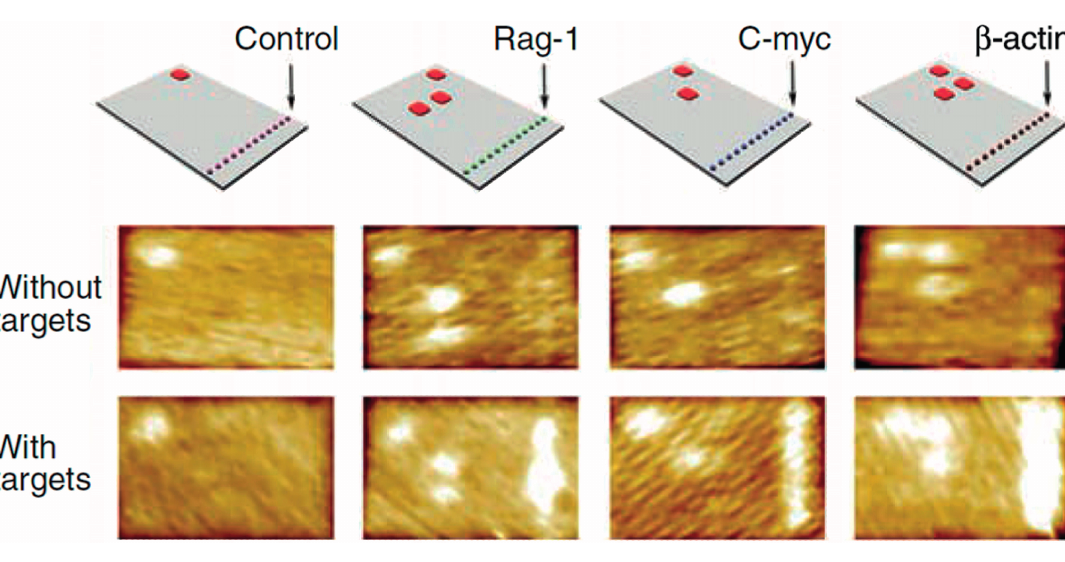
Figure 3. RNA detection using bar-coded DNA origami tiles and AFM analysis. The probe molecules are aligned in a row on the right side of the tiles, and different probes are distinguished from each other with the bar-code located on the top left corner of the tiles. Hybridization is visualized with AFM due to the higher stiffness of double-stranded DNA compared to single-stranded DNA. From Ref. [22]. Reprinted with permission from